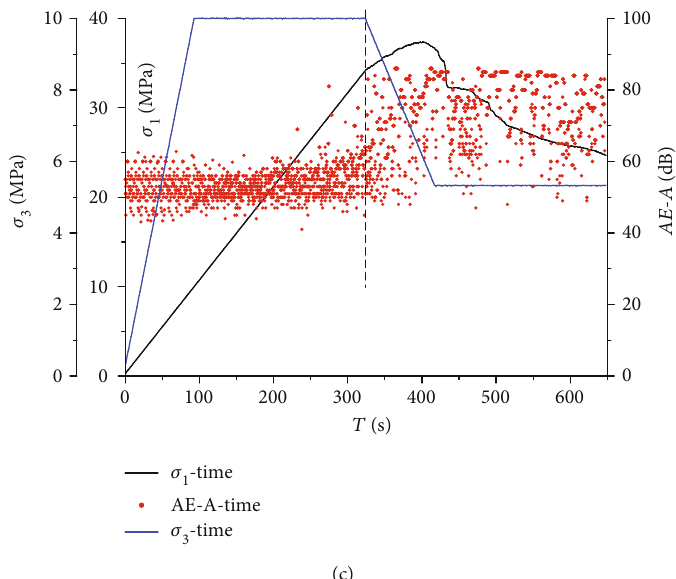
Figure 7: Test results of AE amplitude distribution of rock samples under triaxial compression and unloading